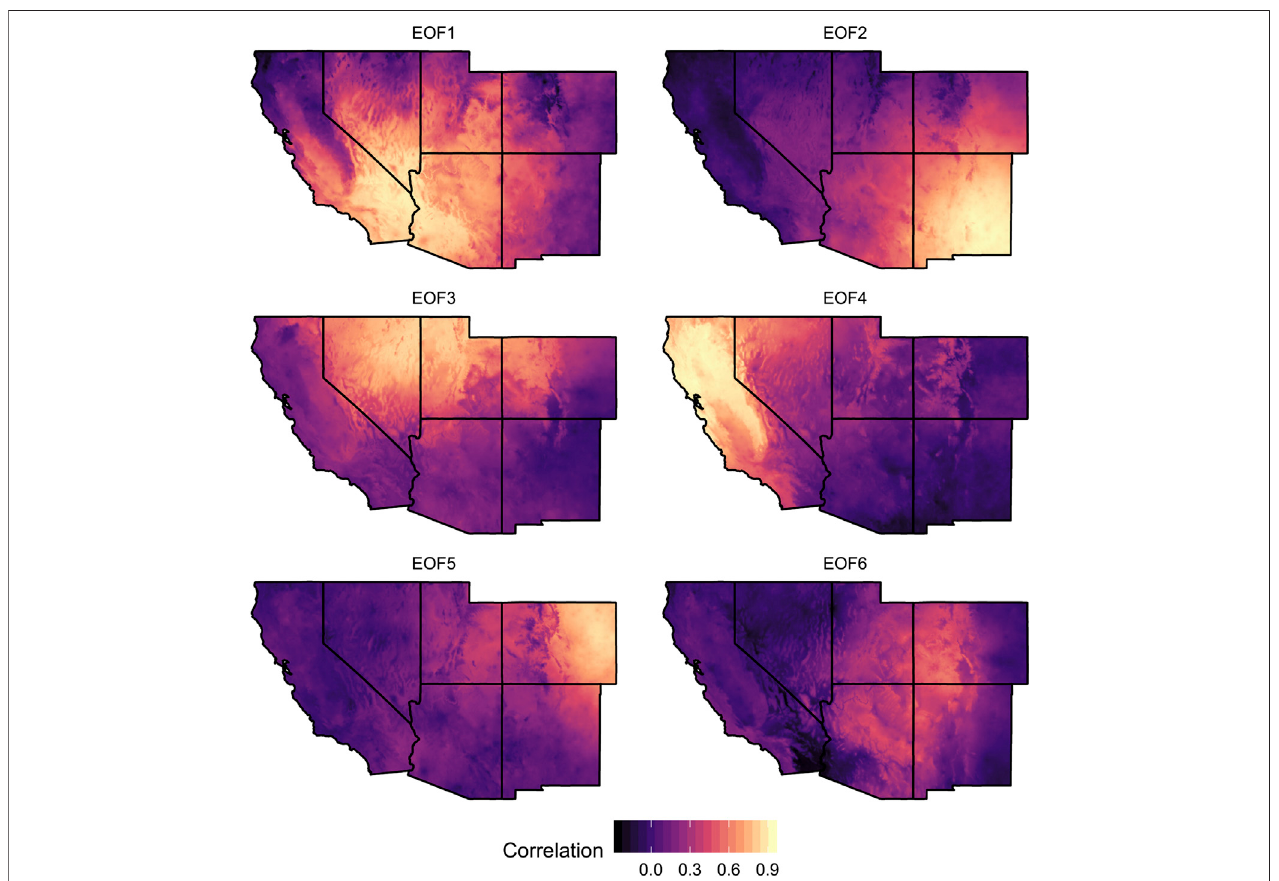
FIGURE 3 | Leading six rotated empirical orthogonal functions (EOFs) associated with the respective PC time series in Figure 2 , derived from gridded PRISM climate data (Daly et al., 2008; Abatzoglou et al., 2017). These regions represent different oceanic and atmospheric in fl uences; people living in the same EOF will often experience dry and wet years at the same time as one